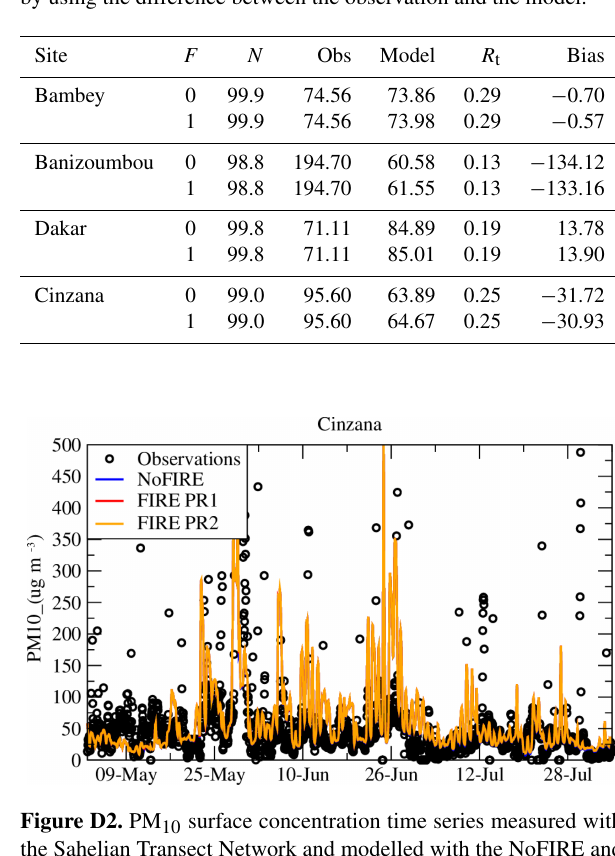
Table D1. Correlations between observations (Sahelian Transect) and the model (CHIMERE PR2) for the PM 10 surface concentra- tions. F is 0 for the NoFIRE simulation and 1 for the simulation with fire emissions. N is the percentage of hourly available mea- surements, R t is the temporal correlation, and the bias is calculated by using the difference between the observation and the model.